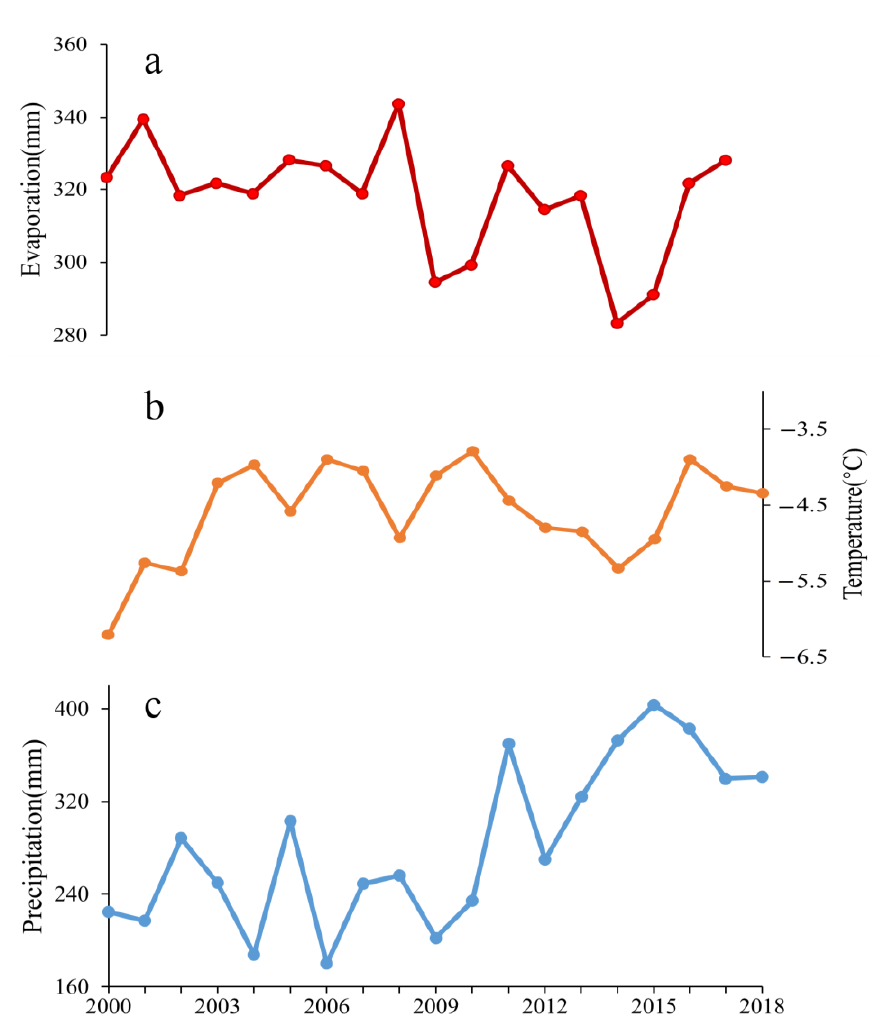
Figure 7. Climate change trends of various elements on the TP. ( a ) Evaporation; ( b ) Temperature; ( c ) Precipitation.